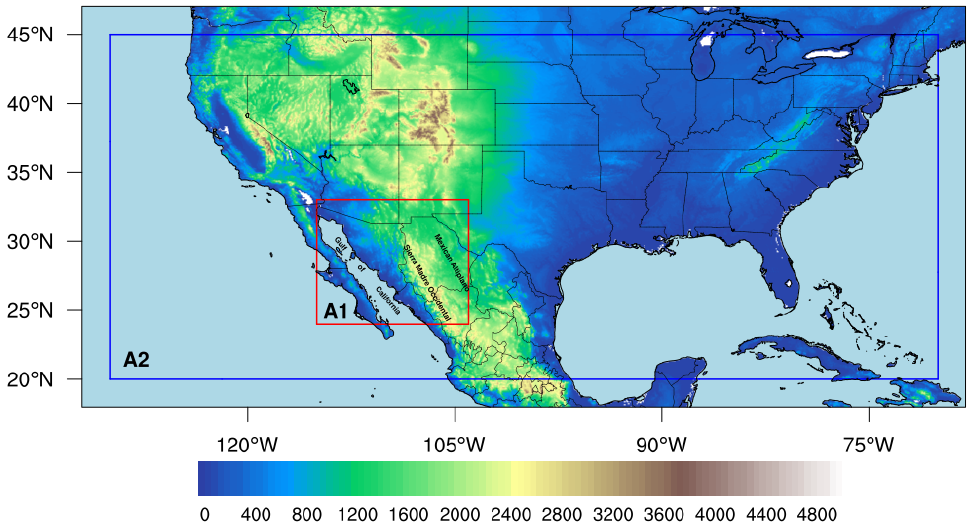
Figure 1. Map of the topography of Mexico and the U.S. The color bar represents elevation in meters above mean sea level. The red (blue) solid line represents the region of study to identify MCS (A1) and to analyze synoptic conditions